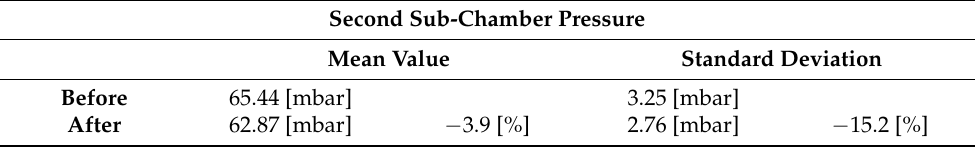
Table 12. Grate cooler APC system: KPI evaluation (second sub-chamber pressure).